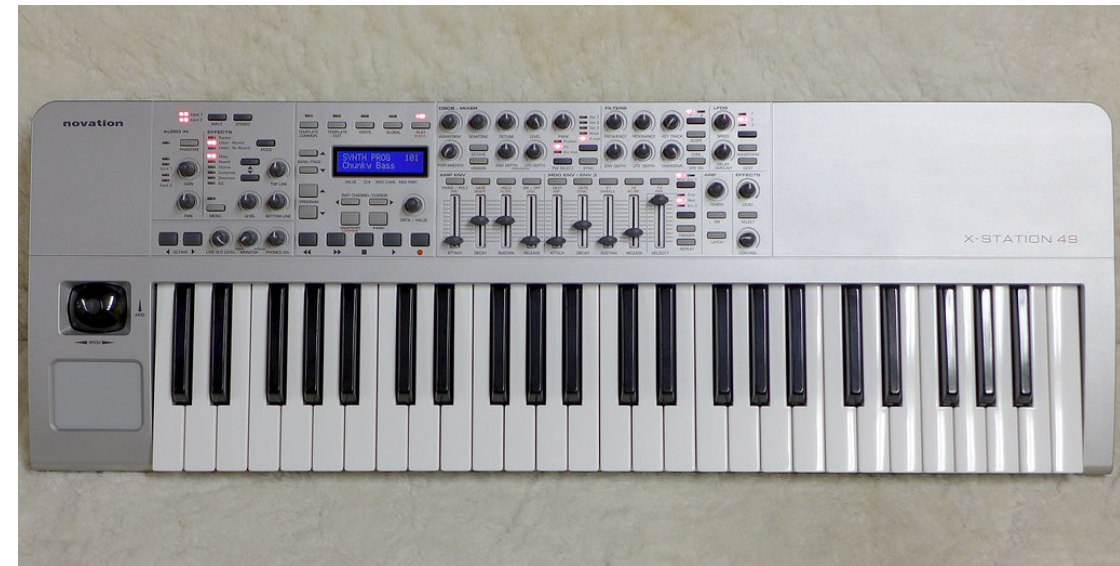
Figure 10. The Novation X-station 49 synthesizer was produced between 2004 and 2009. The design embraces the knobs, buttons and sliders control paradigm we seek to provide an alternative